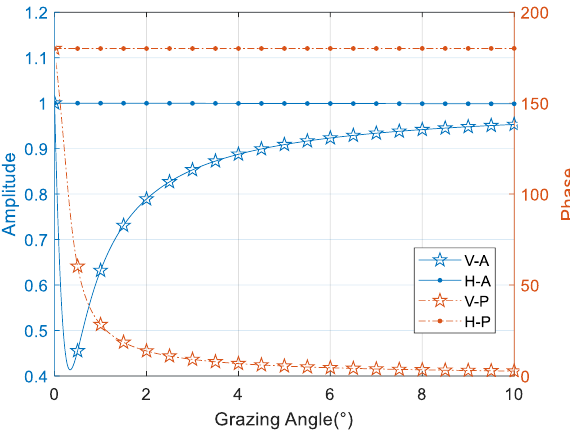
Figure 2. Reflection coefficients properties versus grazing angle at 9 GHz.